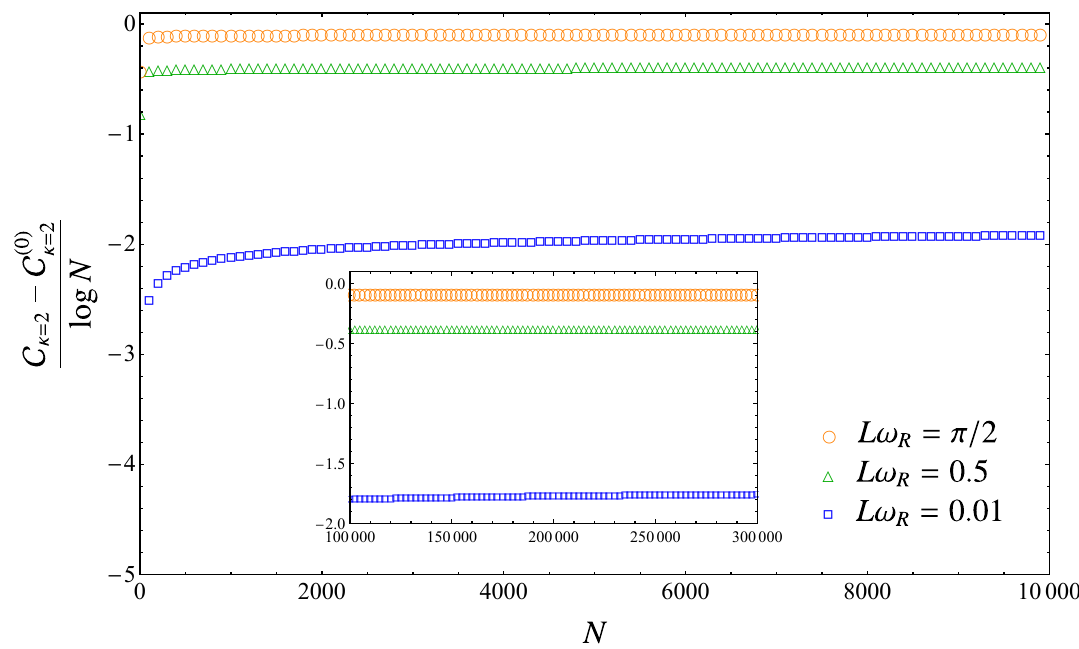
Figure 4 . The logarithmic term of C 2 when ! = 0 for large N (see